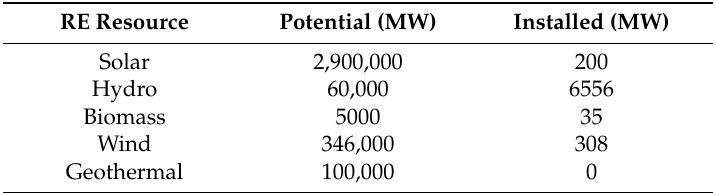
Estimated renewable energy potential of various source and installed capacity in Pakistan [42–44]. RE: renewable energy.